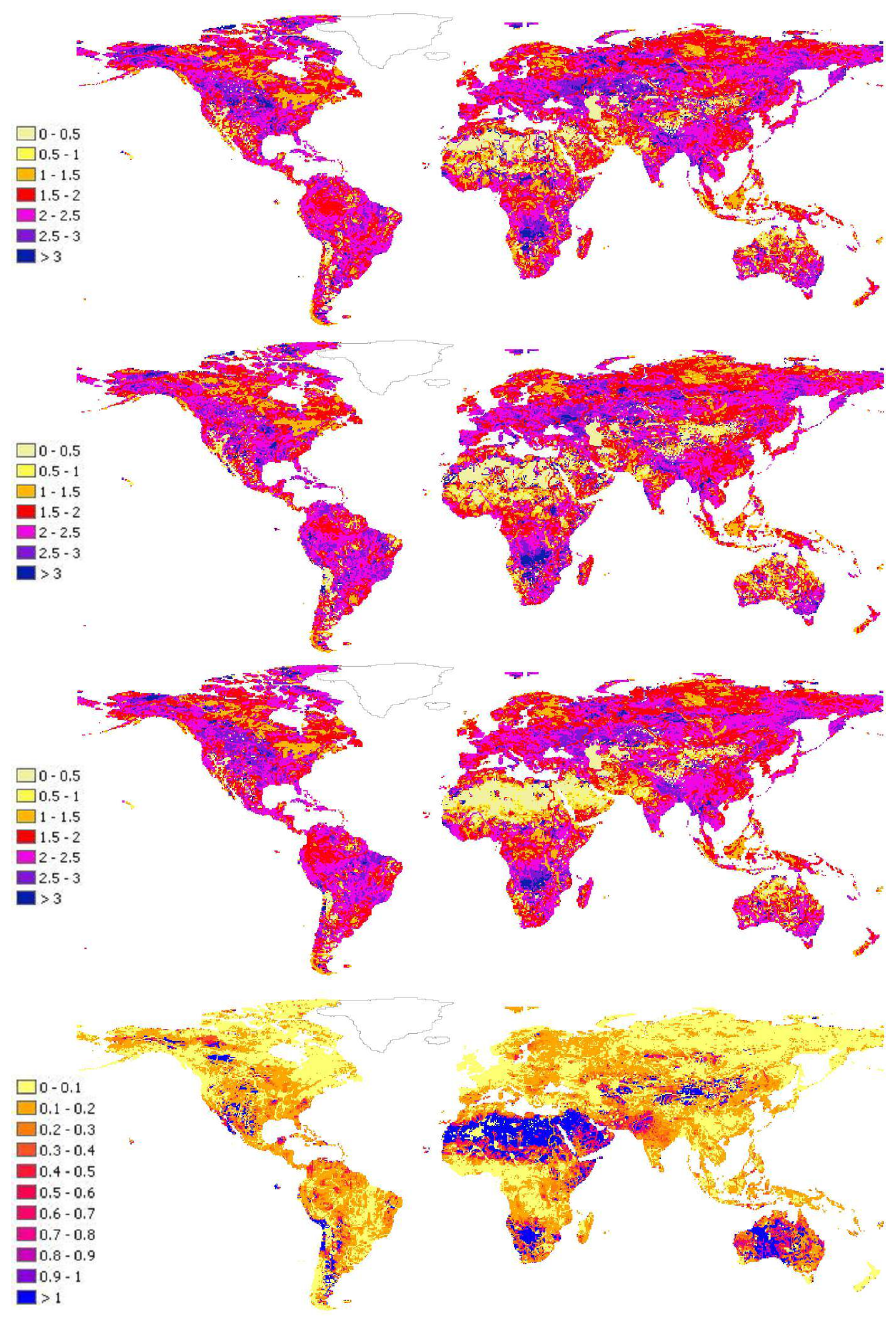
1 Figure 10: Thirty year average relative Q90 values: Q 90 / Q (-) calculated from a) the PCR-2 Fig. 10. Thirty year average relative Q 90 values: Q 90 /Q (–) calculated from (a) the PCR-GLOBWB run forced with the ERA6190 dataset, GLOBWB run forced with the ERA6190 dataset, b) the PCR-GLOBWB run forced with the3 (b) the PCR-GLOBWB run forced with the ERACLM dataset, (c) the ensemble mean discharge results of the 12 GCM based PCR-GLOBWB runs and (d) the CV (–) of the thirty year average Q 90 of the ensemble of ERACLM dataset, c) the ensemble mean discharge results of the 12 GCM based PCR-4 GLOBWB runs and d) the CV (-) of the thirty year average Q 90 of the ensemble of GCMs.5